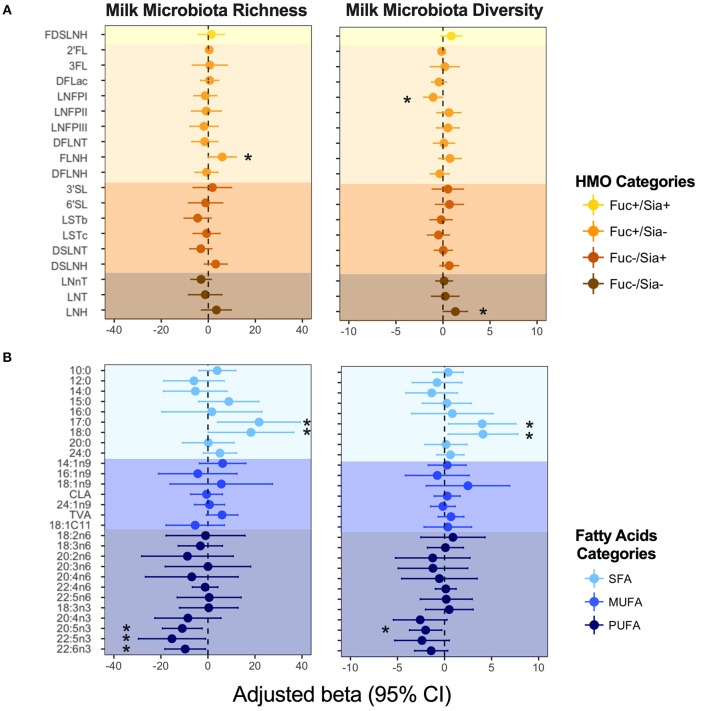
Association of (A) human milk oligosaccharides (HMOs) and (B) fatty acids with milk microbiota richness (observed ASVs) and diversity (inverse Simpson index). Adjusted for mode of breastfeeding, infant sex, parity, and birth mode. Fatty acids and HMOs are colored according to their categories. *denotes significant associations (p < 0.05).